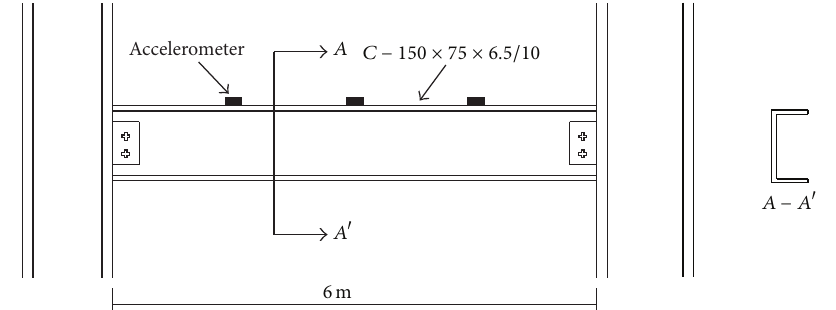
Figure 1: Target structure for damage detection.